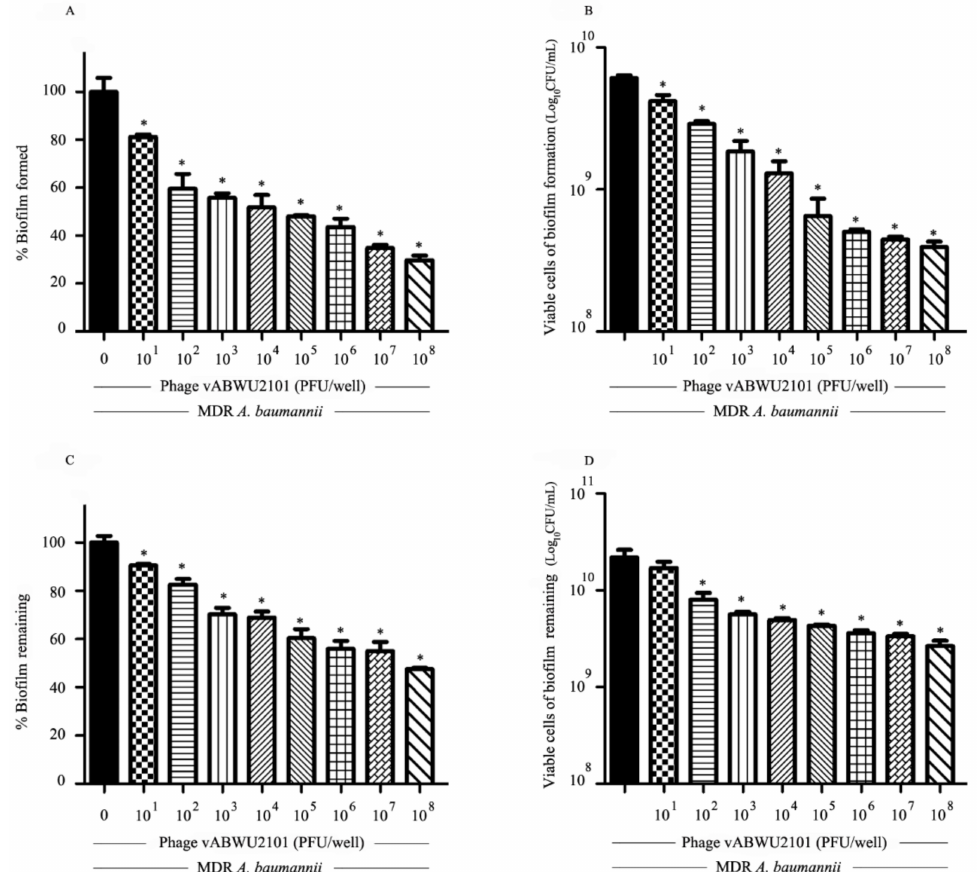
Figure 7. Antibiofilm activity of phage vABWU2101. Effect of phage vABWU2101 on the biomass